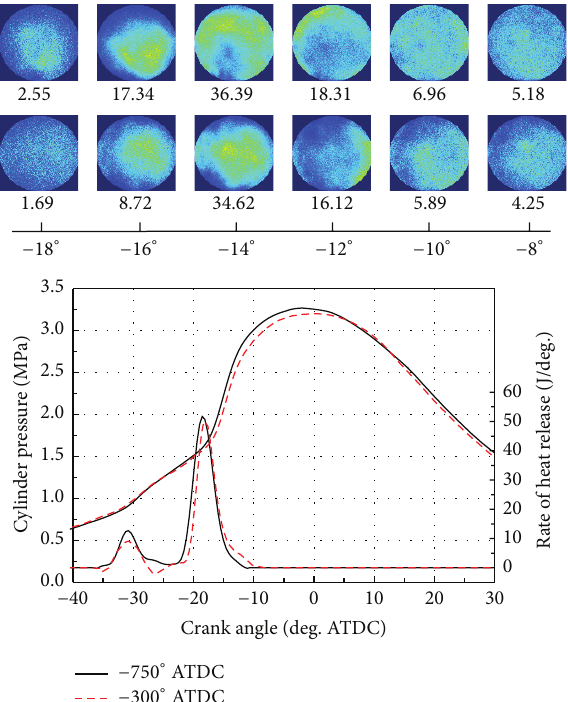
Figure 7: Chemiluminescence images under different intake and coolant temperatures with the same 50% burn point and SOI = − 300 ∘ CA = 95 ∘ C, 𝑇 𝑐 = 85 ∘ C (first) and 𝑇 = 125 ∘ C, 𝑇 𝑐 = 55 ∘ C (last). The number below each image is the light intensity ATDC; 𝑇 in in